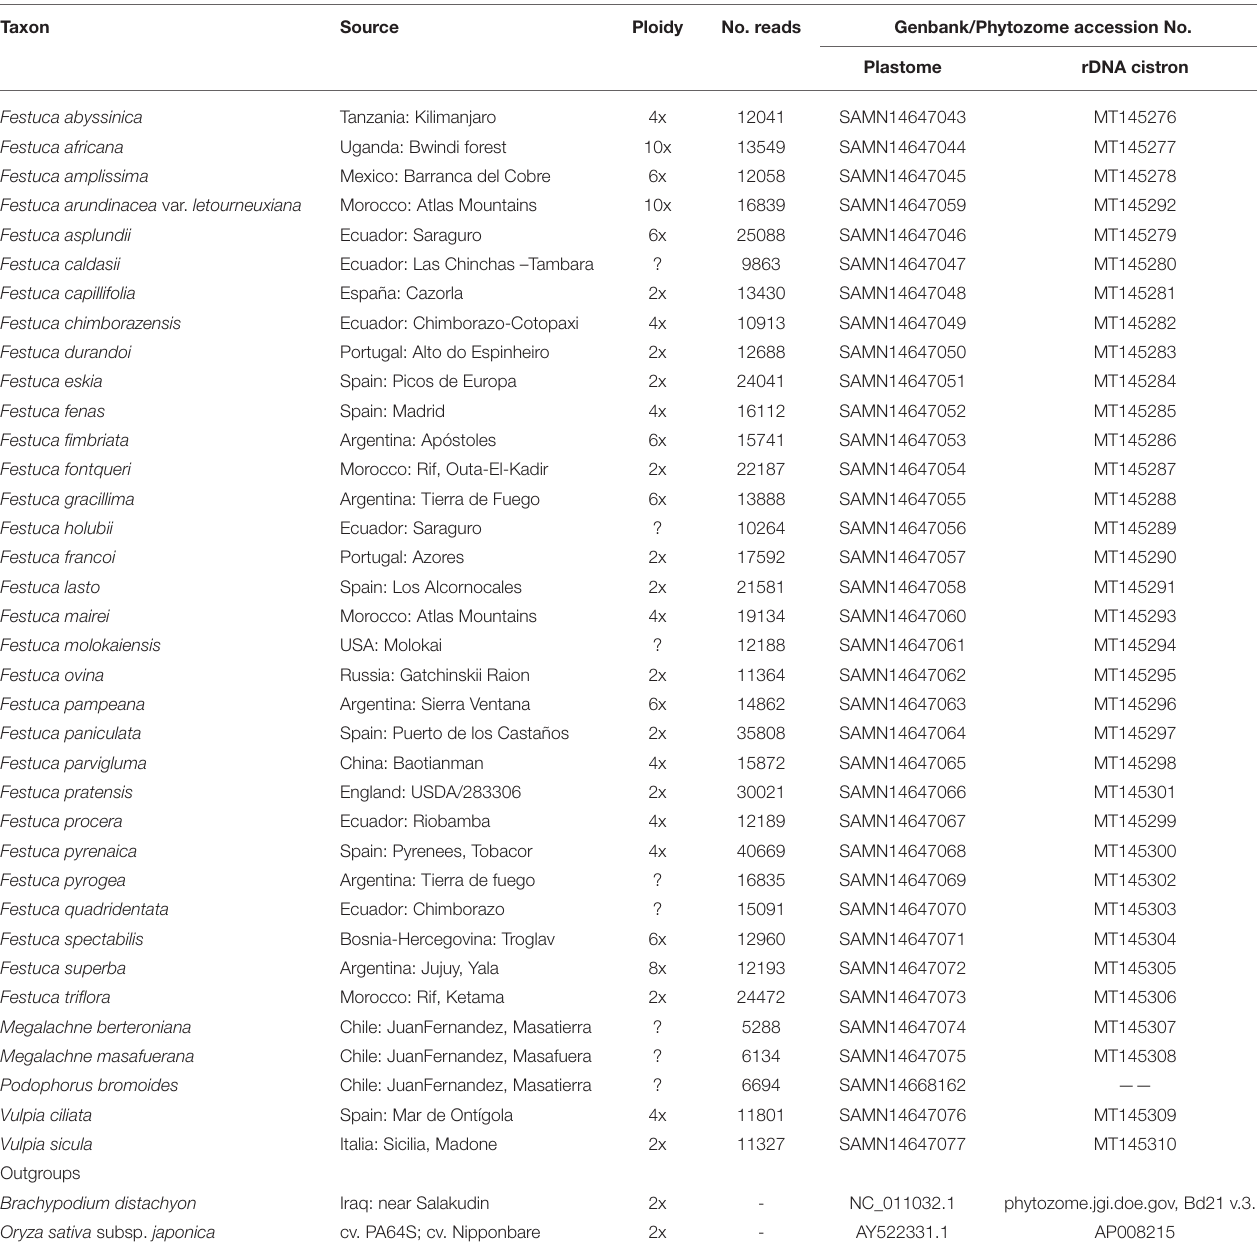
TABLE 1 | List of taxa included in the phylogenomic study of the Fernandezian and other Loliinae